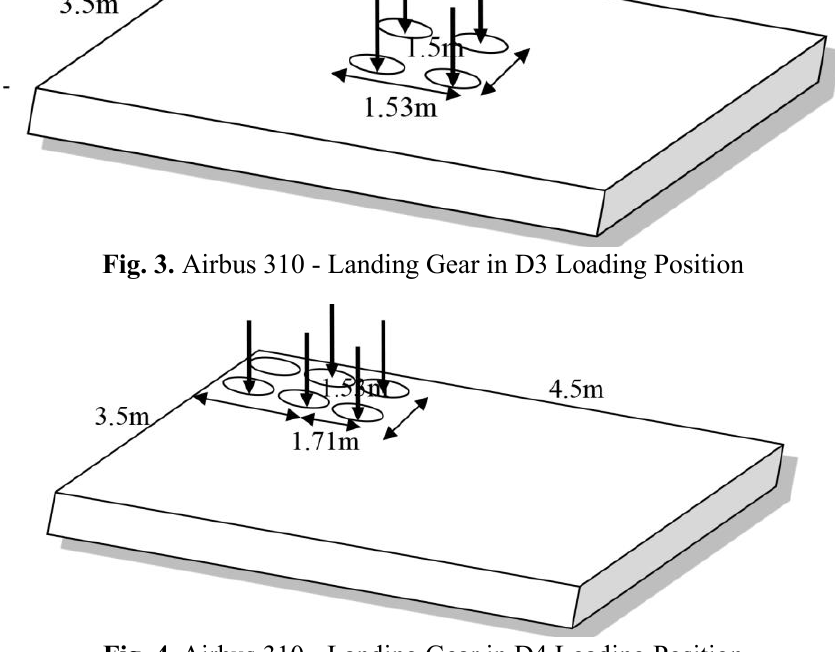
Fig. 4. Airbus 310 - Landing Gear in D4 Loading